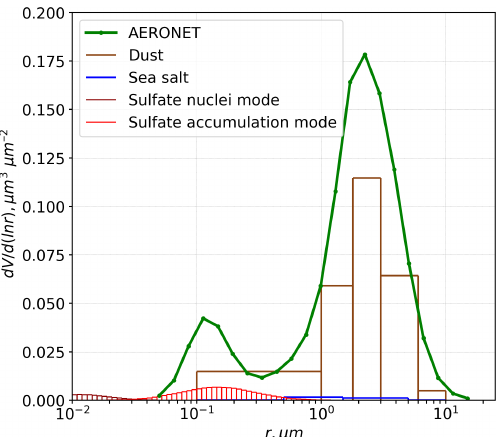
Figure 5. Summer (JJA) averaged 2015–2016 AVSD (µm 3 µm − 2 ) at the KAUST Campus AERONET site obtained from the AERONET inversion algorithm and from